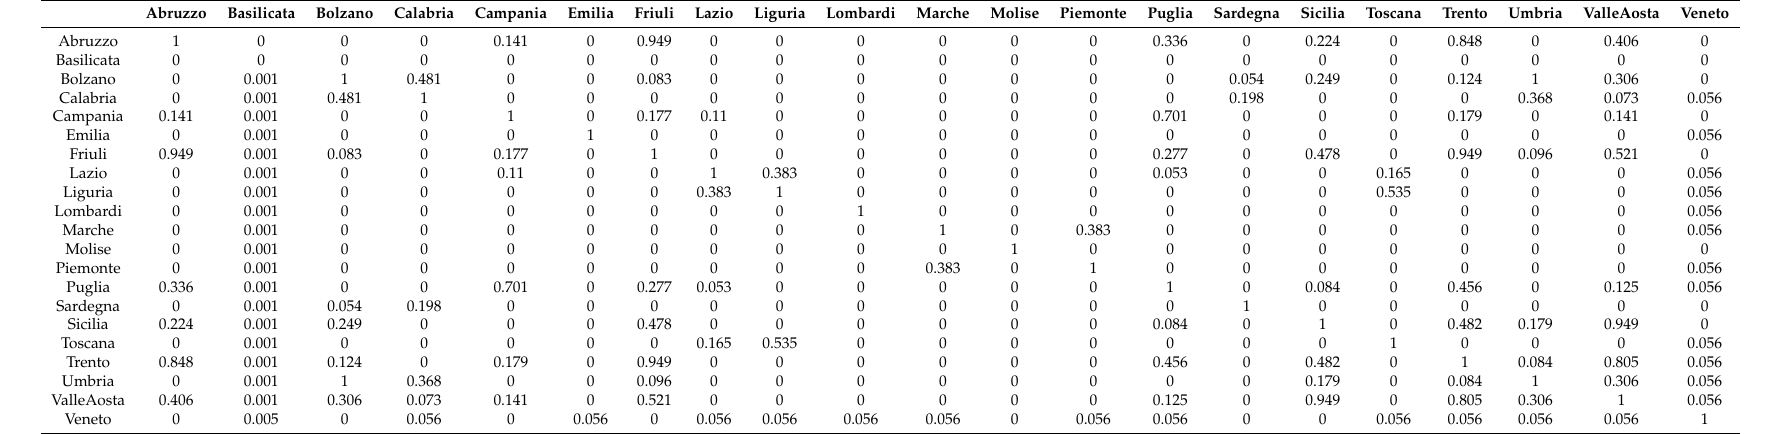
Table A16. Similarity values of Total Hospitalized network in the third